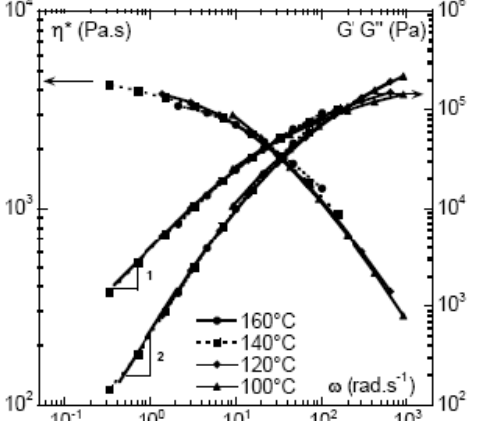
Figure 5. Time-temperature superposition of the SPSFNa (IEC = 1.3 Na + /kg) + 40% PEG blend, Reference temperature = 160